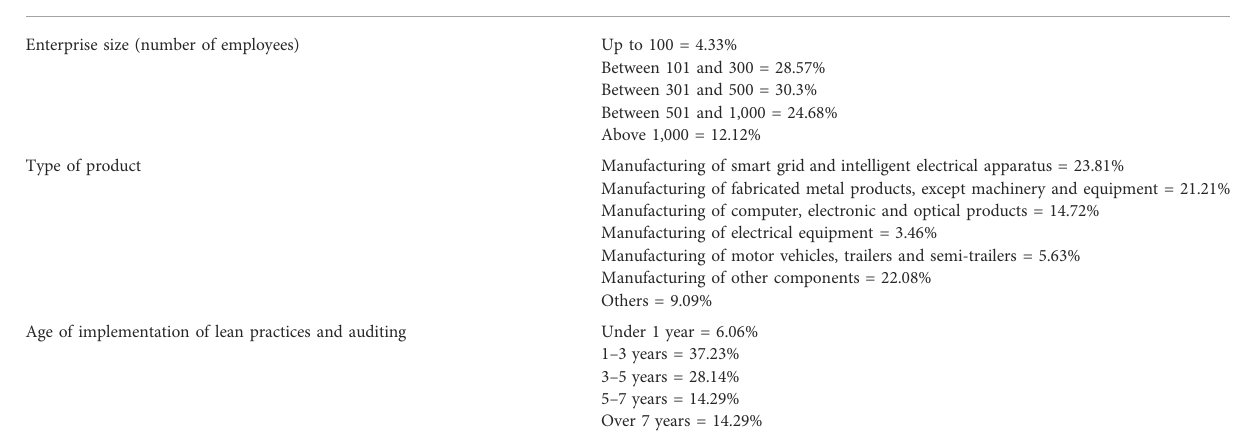
TABLE 2 Sample pro fi le. Characteristic Pro fi le Enterprise size (number of